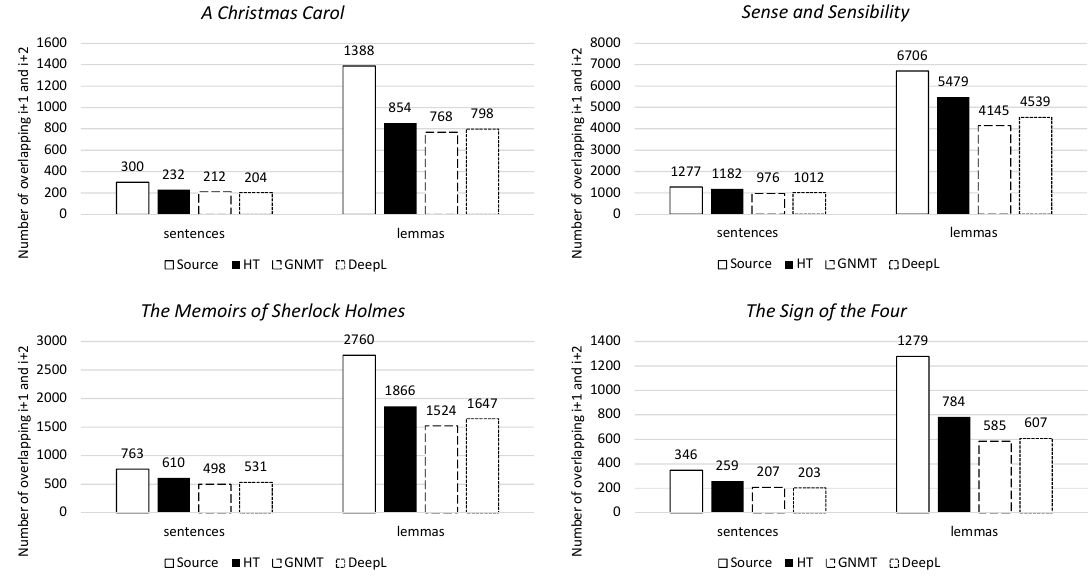
Figure 9. Semantic cohesion for i+1 and i+2 per novel, on both sentence and lemma